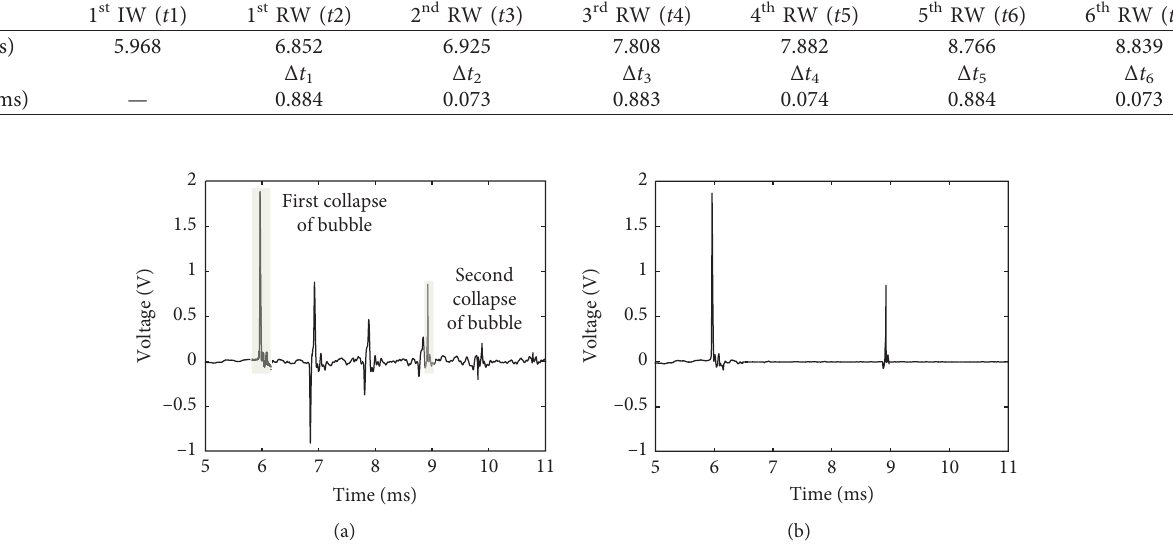
Figure 8: Data analysis in this paper. (a) The original signal. (b) Stress waves of bubble collapse only.